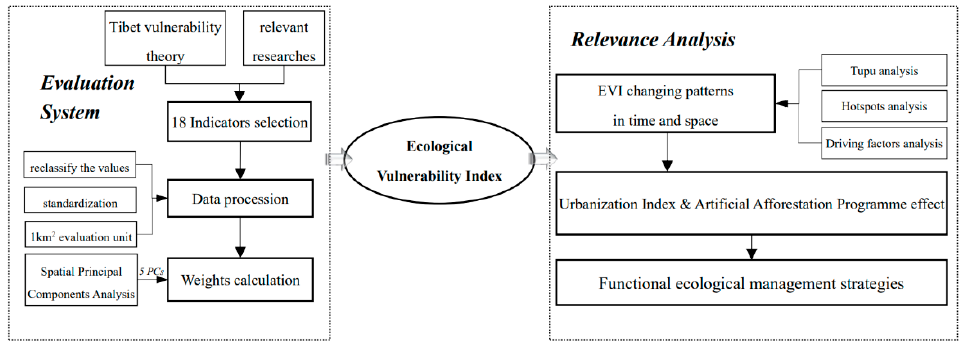
Figure 2. The technique flowchart of the